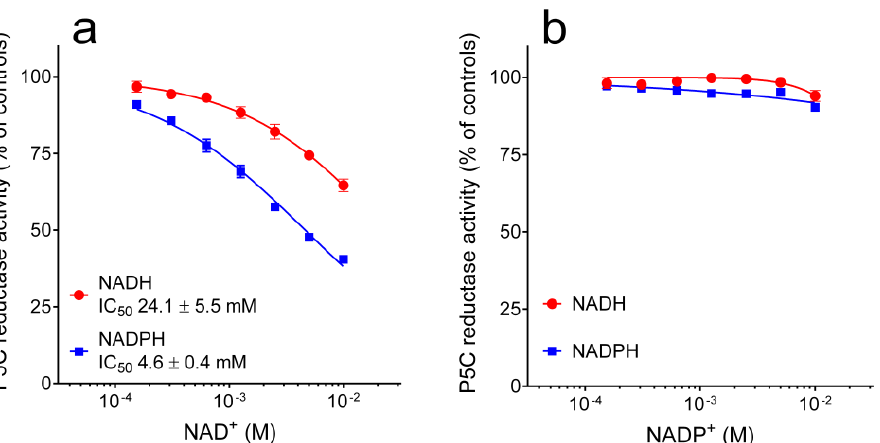
Figure 3. Effect of oxidized pyridine dinucleotides on the activity of yeast P5C reductase. The purified enzyme was assayed in the absence or in the presence of increasing concentrations of NAD + ( a ) or NADP + ( b ), using either NADH or NADPH as the electron donor. Results were expressed as percent of the activity obtained with untreated controls. Data are means ± SE over three replicates.